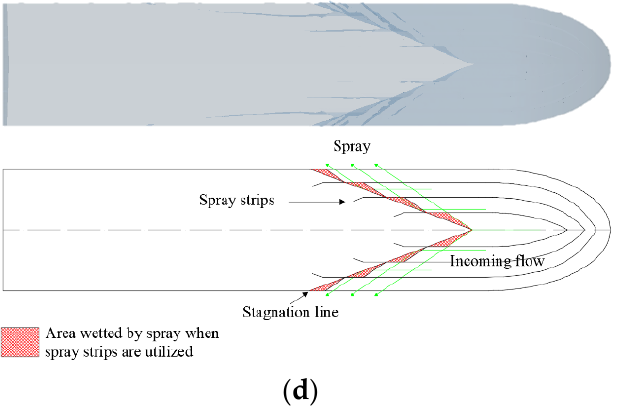
Figure 8. The comparison spray areas: ( a ) bare hull; ( b ) 1 strip; ( c ) 2 strips; ( d ) 3 strips. Figure 9 shows a volume fraction that represents air and water fluids. The red color showed a value close to 1 as a representation of air, and the blue color was close to 0 as a representation of water. The problem occurs when the Volume of Fluid method is used to model a high-speed vessel with a bow that creates a trim angle on the free surface. The Numerical Ventilation in the high-speed vessel is the entrainment of air under the hull of a vessel. However, the mixture of water and air cannot distinguish between real ventilation and numerical ventilation in a simulation. As previously discussed [11], the strategy used to reduce Numerical Ventilation (NV) is High-Resolution Interface-Capturing (HRIC) Modification [28] and mesh refinement around the ship bow area [20].